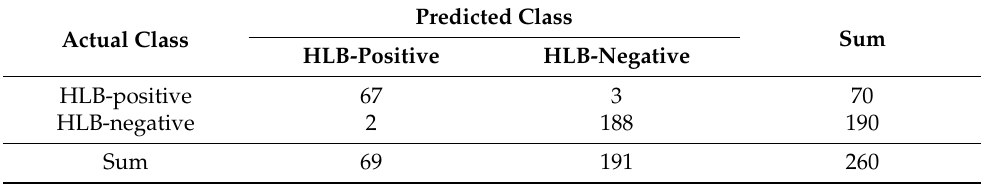
Table 3. Results of classification of the infection status of